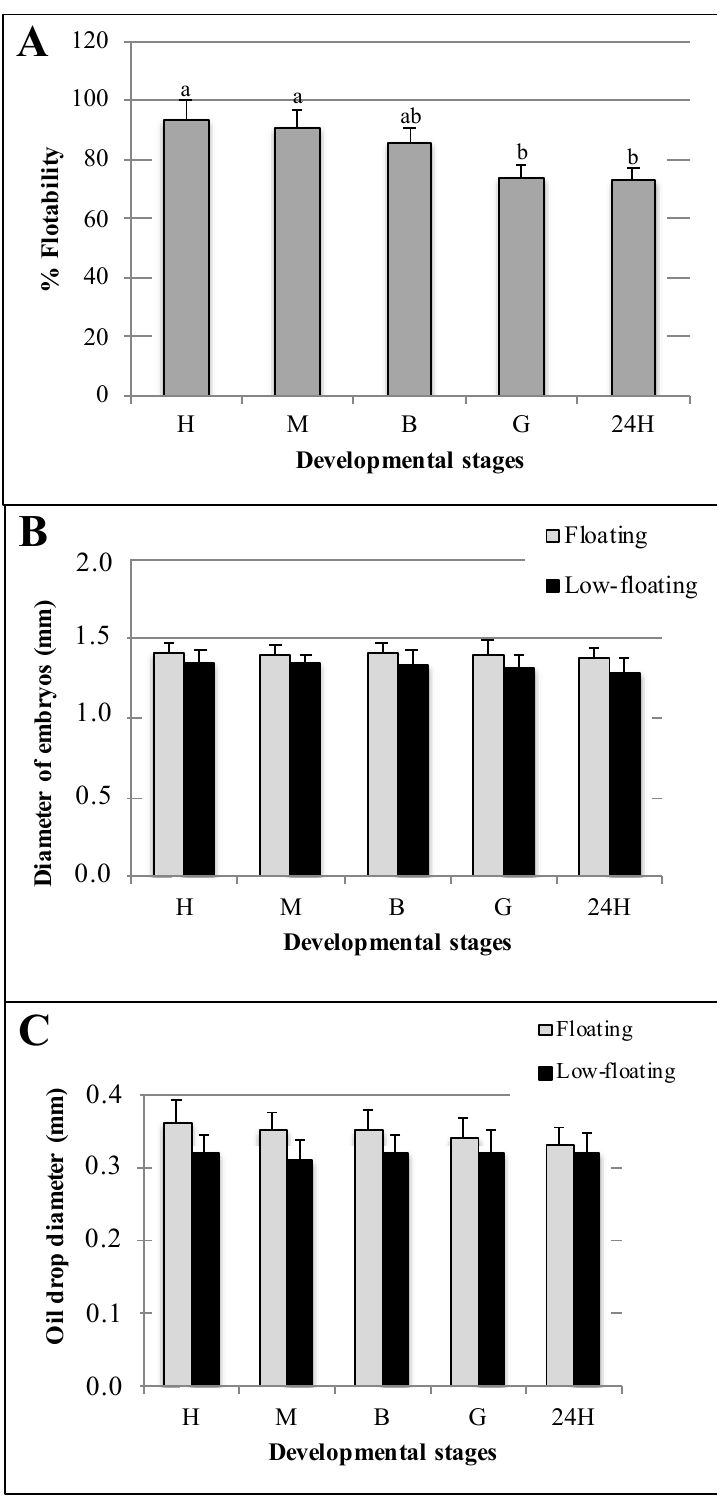
Figure 2. Morpho-biometric parameters of batches ( A ) and embryos ( B , C ) assessed in this study. Buoyancy level (% Floatability) observed in each developmental stage ( A ). Total embryo ( B ) and oil drop ( C ) diameters observed in both floating (gray bars) and non-floating (black bars) embryos. Fertilized eggs, morula, blastula and 24 h post-fertilization embryos are identified as E, M, B, G and 24H, respectively. Bars represent mean ± standard deviation (SD) of six biologicals replicates, and the different letters indicate significant differences ( p < 0.05) assessed using Tukey’s test.